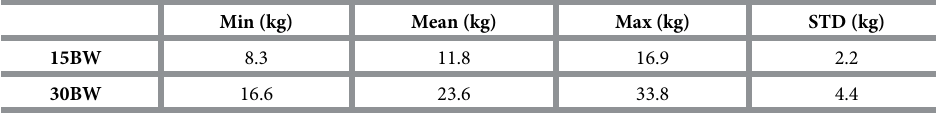
Table 1. Minimum, mean, maximum, and standard deviation (STD) of additional loads (in kg) secured to the